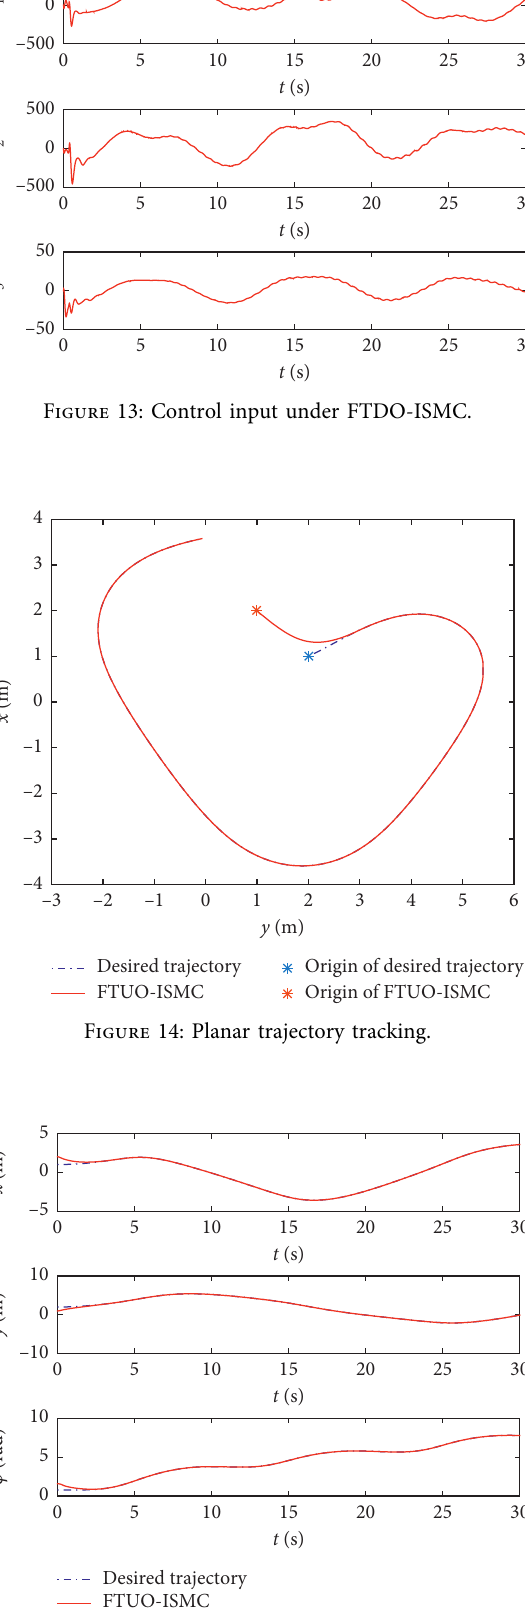
Figure 15: Position tracking on